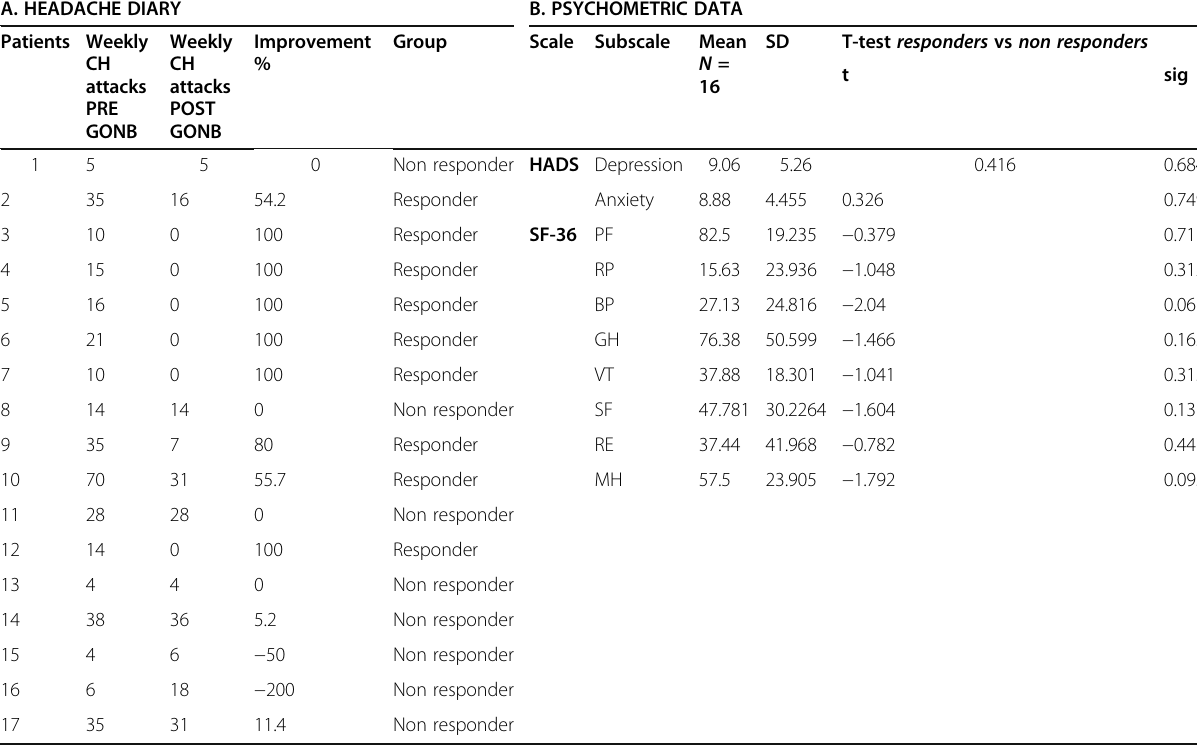
Table 2 Behavioural data from Headache Diary (A), as well as from HADS and SF-36 questionnaires [29] A. HEADACHE